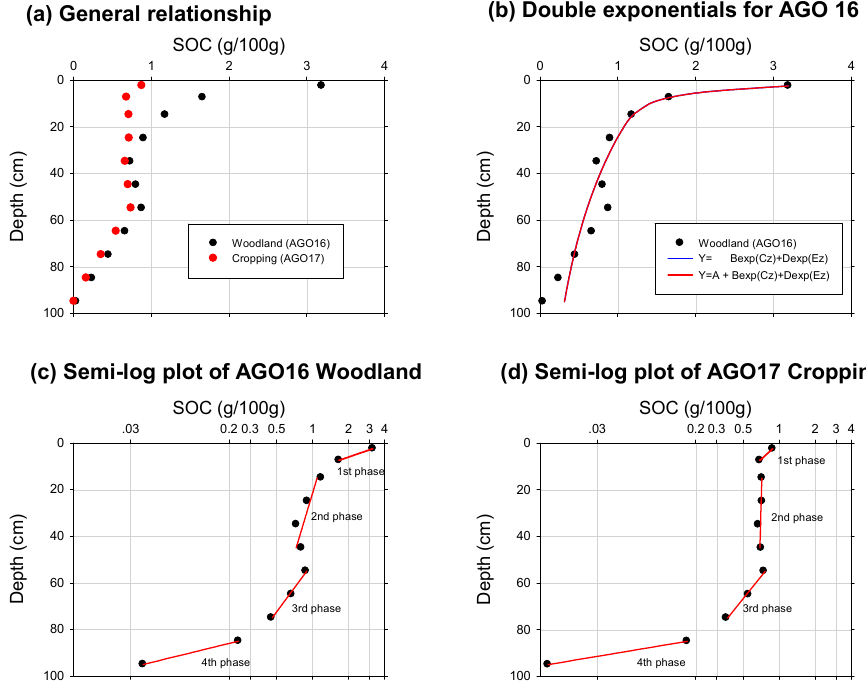
Figure 8. SOC profiles with complex depth distributions. These do not follow clear relationships and the functions showed a poor fit or could not be fitted to the mathematical functions. ( a ) Profiles AGO 16 and 17 are adjacent soils from a paired site, AGO 16 being a native vegetation site dominated by Acacia pendula. ( b ) Double exponential models showing lack of fit. Phases derived subjectively from inspection of scatterplots for semi-log functions are labelled in ( c ) for AGO16 Woodland and ( d ) AGO17 Cropping. Note the natural logarithmic scale for graphs ( c , d ).